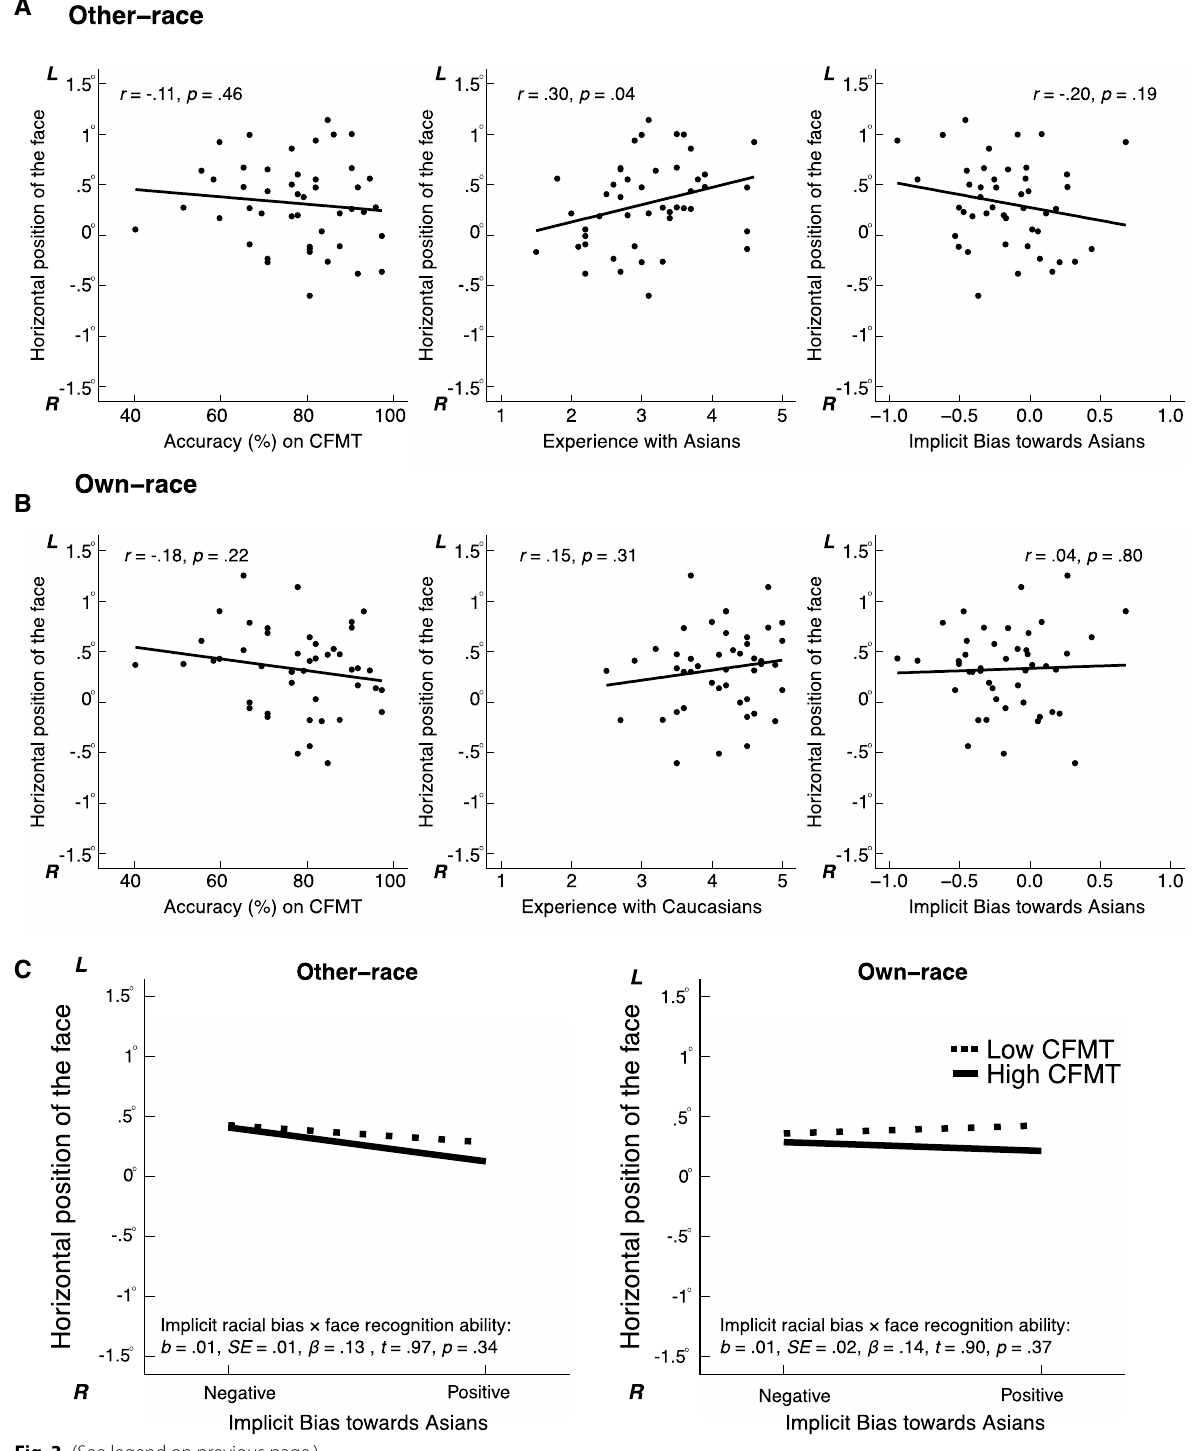
Fig. 3 (See legend on previous